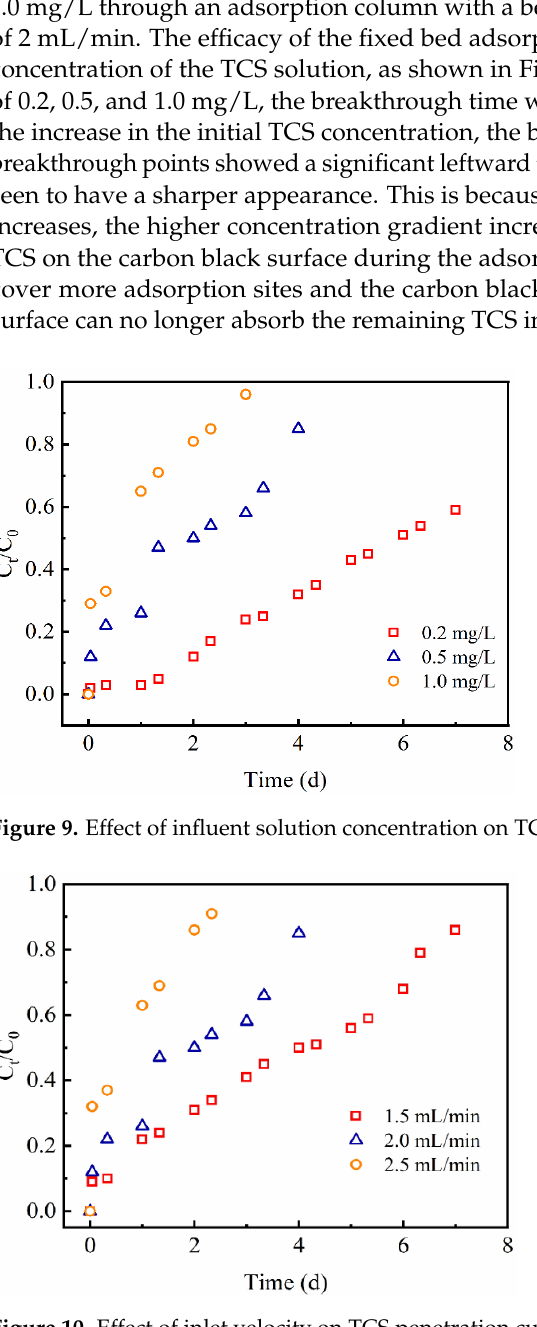
Figure 10. Effect of inlet velocity on TCS penetration